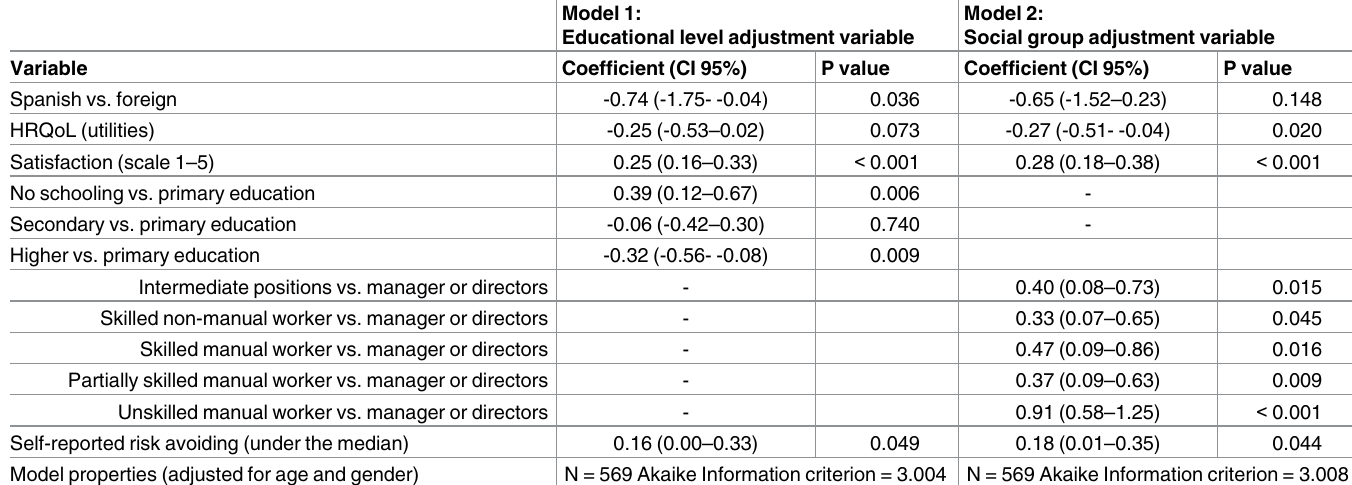
Table 2. Factors explaining the WTA/WTP ratio, measuring self-reported risk score.